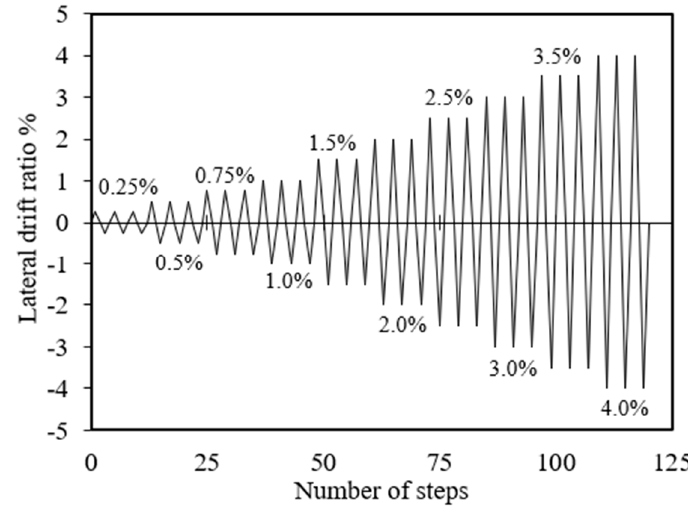
Figure 5. Displacement-controlled loading history.